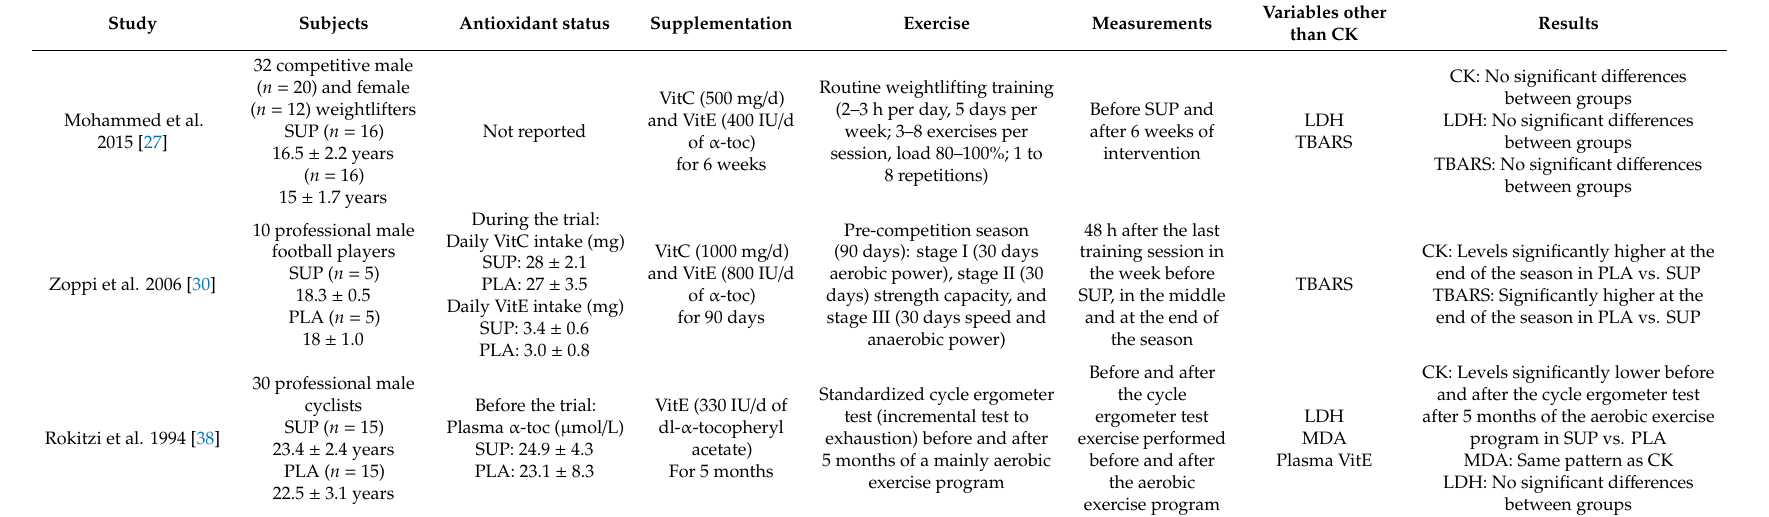
Table 4. Summary of studies reviewed examining the e ff ects of chronic supplementation with VitC and / or VitE over a long period of